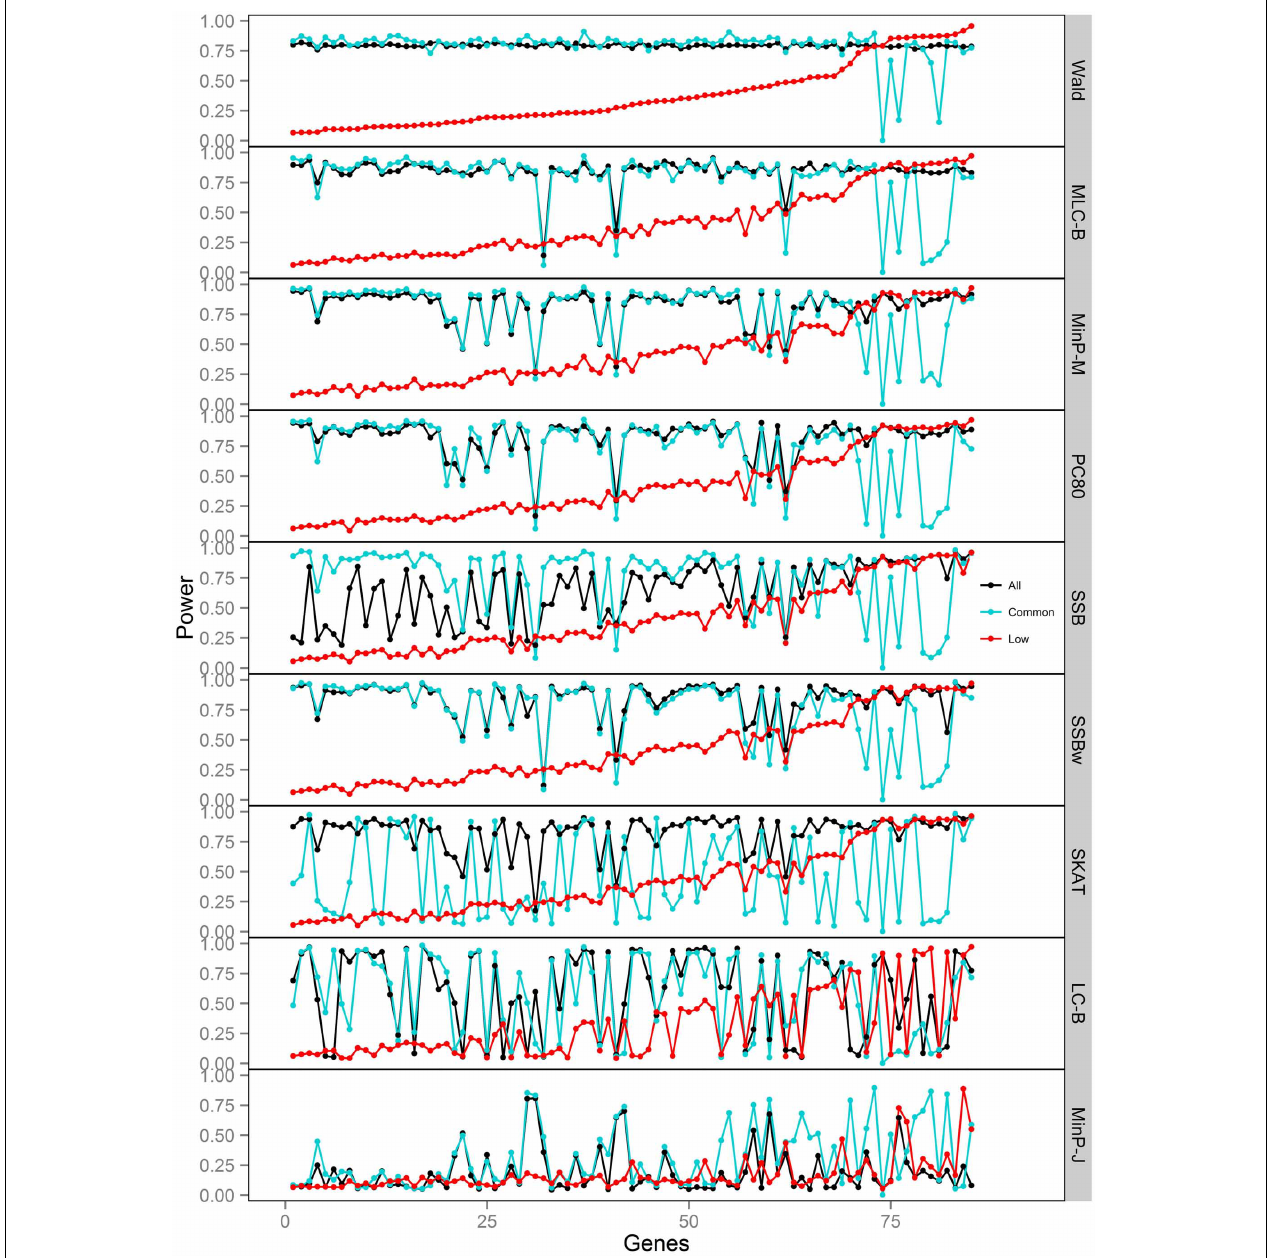
FIGURE 6 | Power of gene-based tests using three analysis sets of SNPs for 85 genes under trait Model 4. Genes are ordered along the horizontal axis according to the empirical power of Wald test using only low frequency